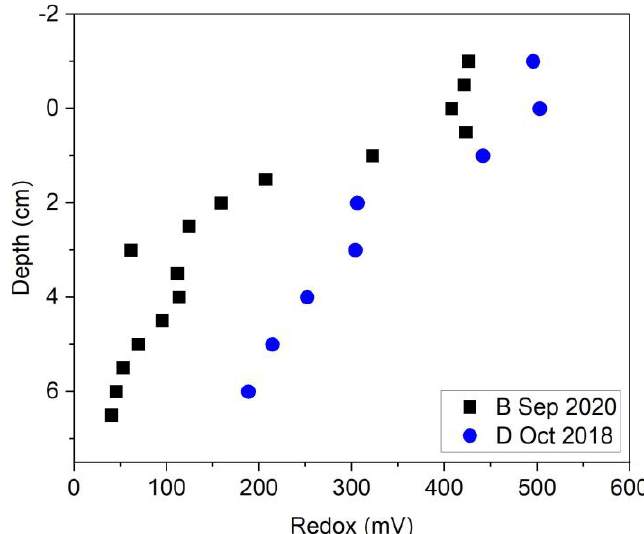
Figure 9. Redox potential in L5 at Constitution Park (2018 and 2020); on the y-axis, 0 represents the water/sediment interface and the negative numbers refer to distances above the interface (i.e., in the water column).